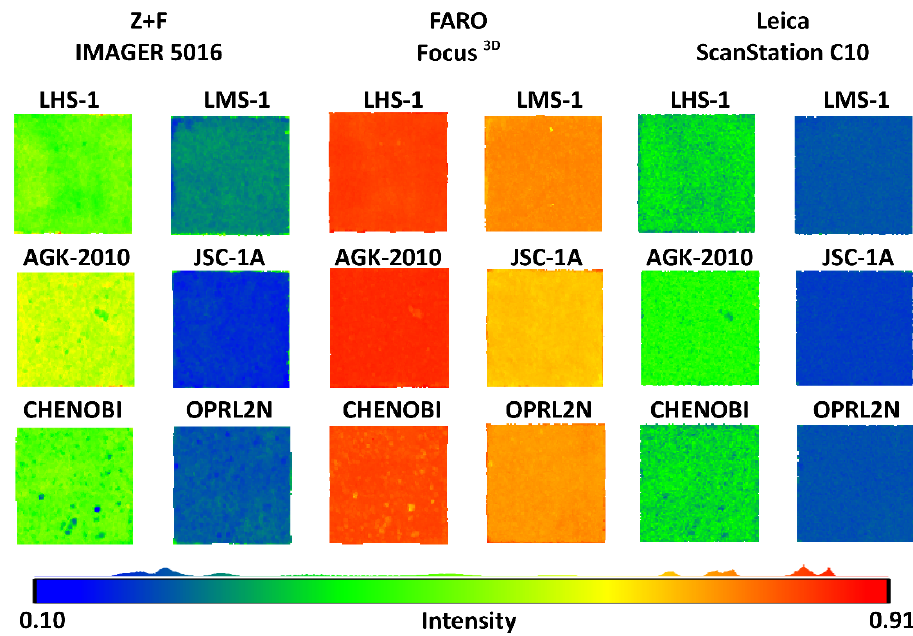
Figure 3. Point cloud intensities collected by TLS of LSS targets at a distance of 5 m.